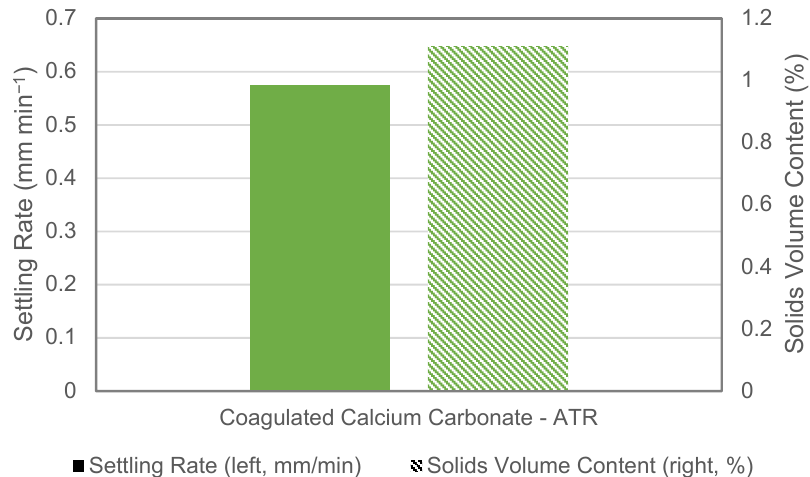
Figure 10. Settling rate (left-hand axis) and increase in solids volume content (right-hand axis) for coagulated calcium carbonate obtained from the ATR after 90 min of operation (using a 15 min reactor residence time).